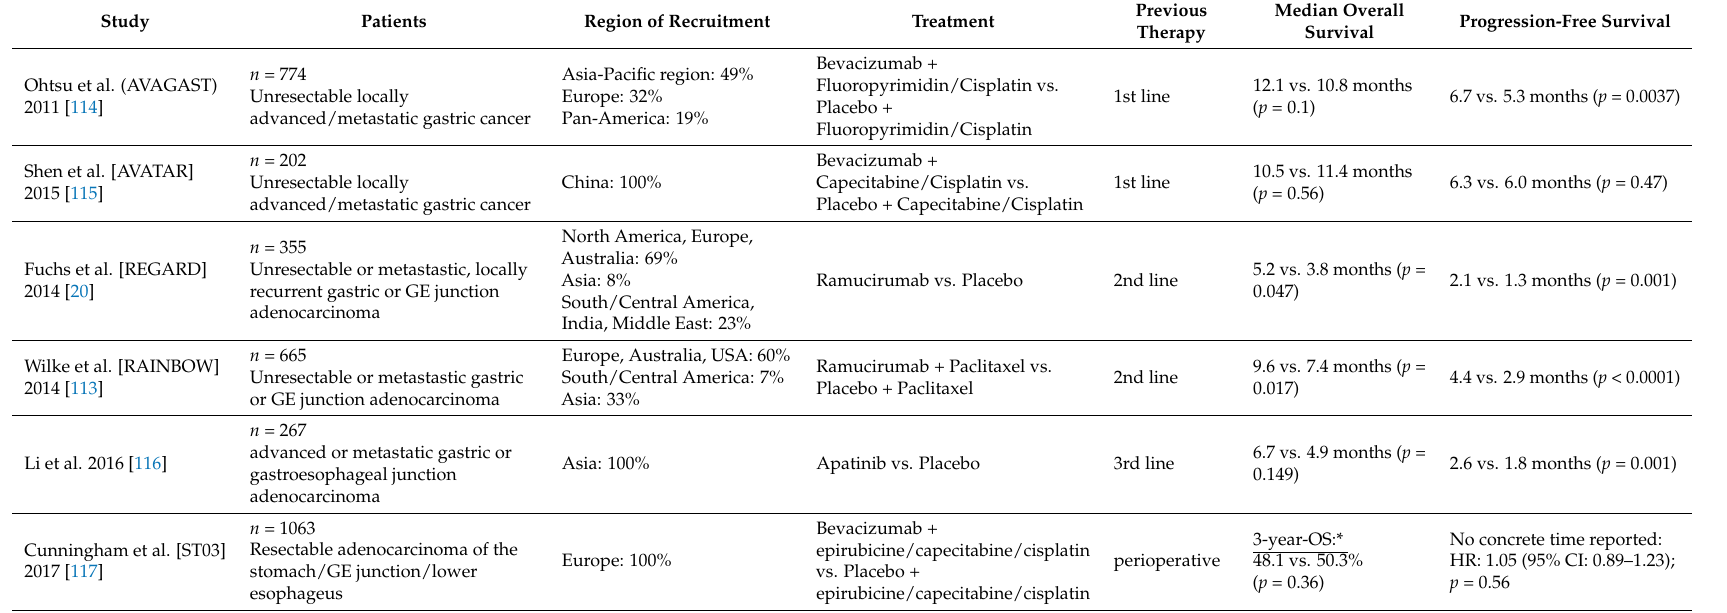
Table 2. Overview of phase-III studies in gastric cancer including anti-angiogenic